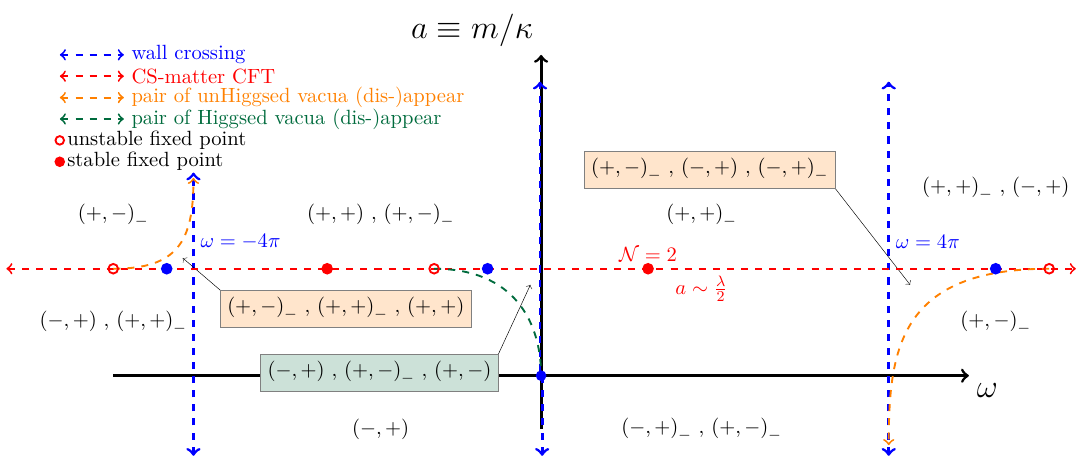
Figure 11. The proposed phase diagram at large but finite N for small λ . The red line is not exactly horizontal, and its slope must be